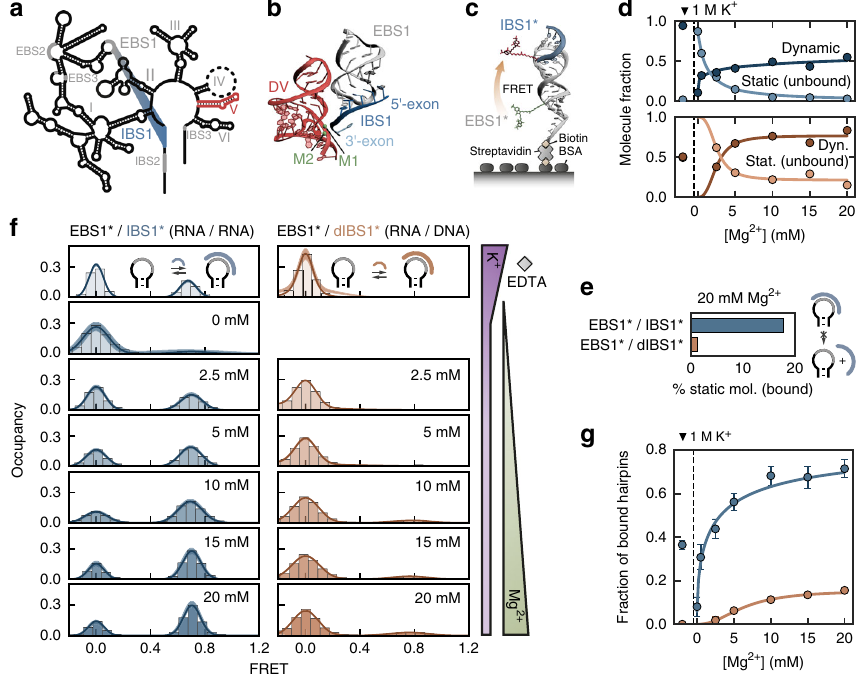
Fig. 1 Thermodynamics of Mg 2 + -induced tertiary contact formation from single-molecule FRET. a Secondary structure of the group IIB intron Sc. ai5 γ with the exon – intron binding site 1 (EBS1/IBS1, gray/blue) and the catalytic domain V (red). b Crystal structure of the active site of the P.li. LSUI2 intron (PDB: 4R0D 8 ) featuring domain V (DV, red), EBS1/IBS1 (gray/blue), and two catalytic metal ions (M1/M2, green). c Surface-immobilized FRET model system EBS1*/IBS1* labeled with Cy3 and Cy5 (BSA, streptavidin, and biotin are not drawn to scale). d Relative abundance of dynamic and statically unbound IBS1* (blue) or dIBS1* (orange) molecules as a function of Mg 2 + . e Percentage of long-lived, statically bound molecules at 20 mM Mg 2 + and 100 mM K + . f FRET histograms of dynamic molecules showing a rising population of the high FRET state with increasing Mg 2 + concentration. g Fraction of EBS1* hairpins bound to ( d ) IBS1* as a function of the Mg 2 + concentration calculated from the integrals of the FRET states. Error bars correspond to the mean ± 2 s.d. of 100 bootstrap samples. Source data are provided as a Source Data fi